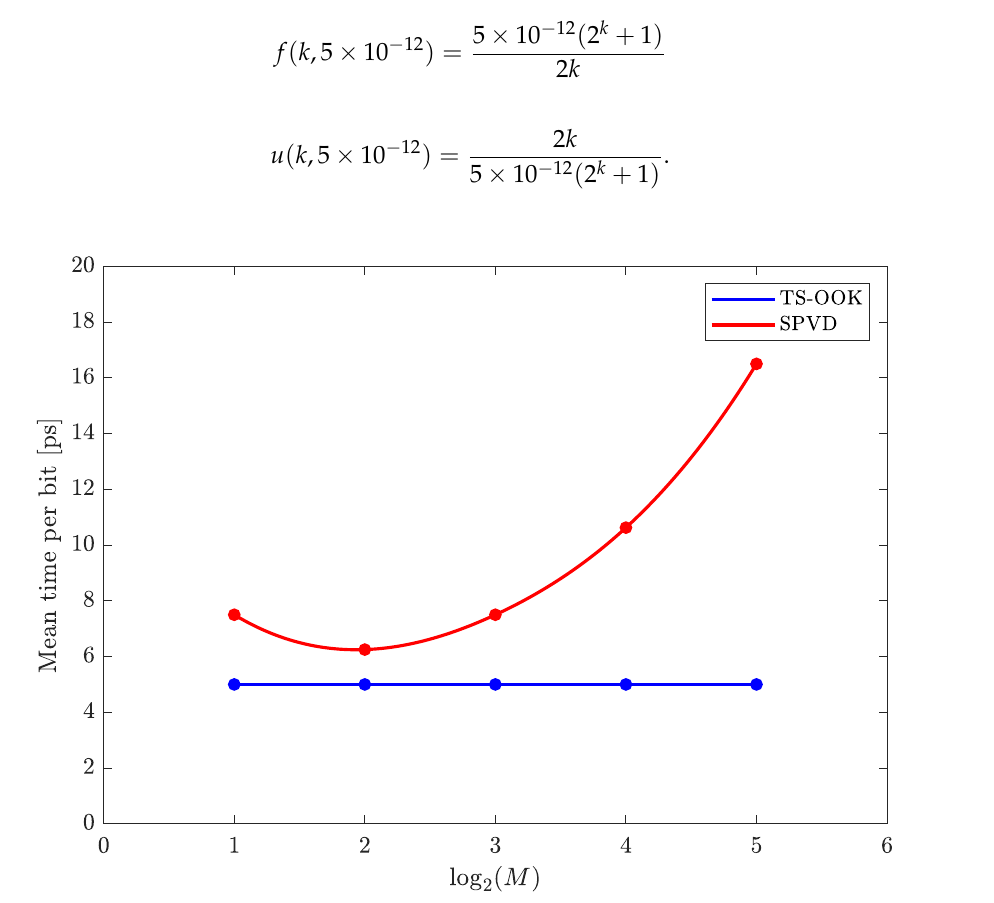
Figure 4. Average Time per